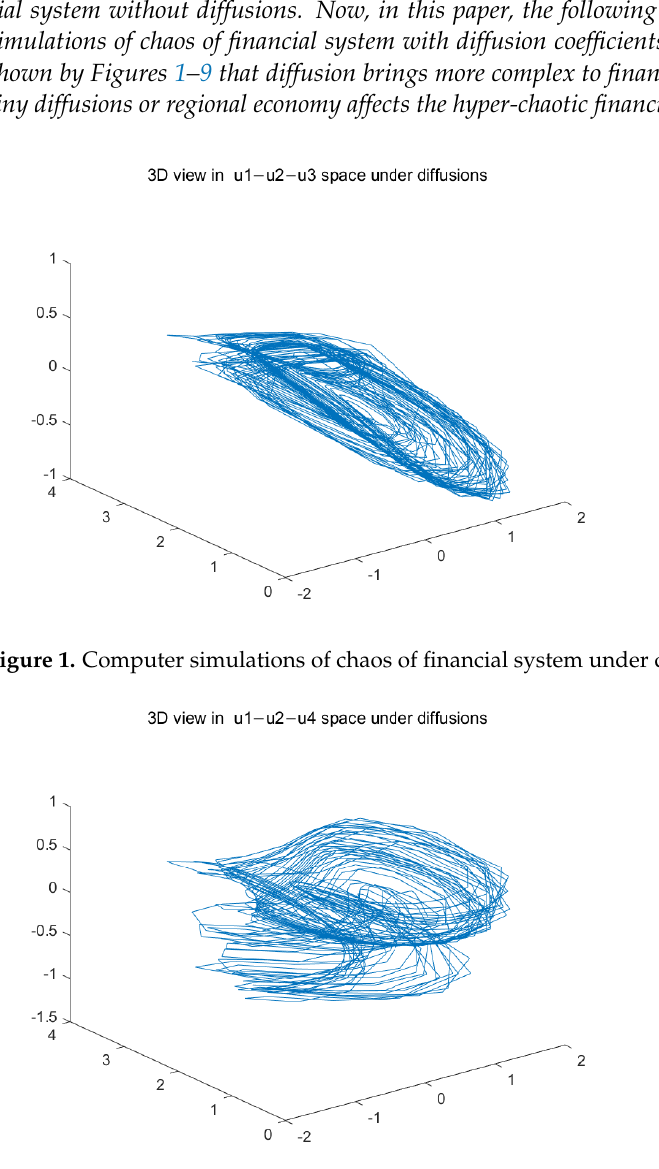
Figure 2. Computer simulations of chaos of financial system under